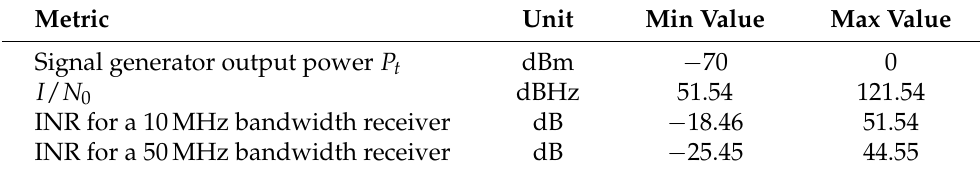
Table 1. Comparison of interference power